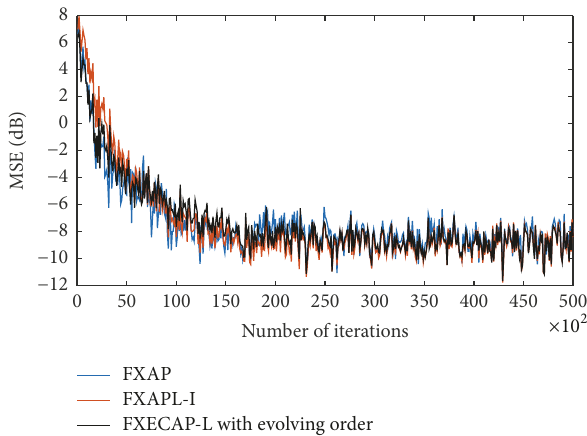
Figure 13: MSE values of the tested AP algorithms as measured at error sensor 1 for a projection order of 𝐿 = 5 when 𝑏 = 8 bits are used to encode the error.